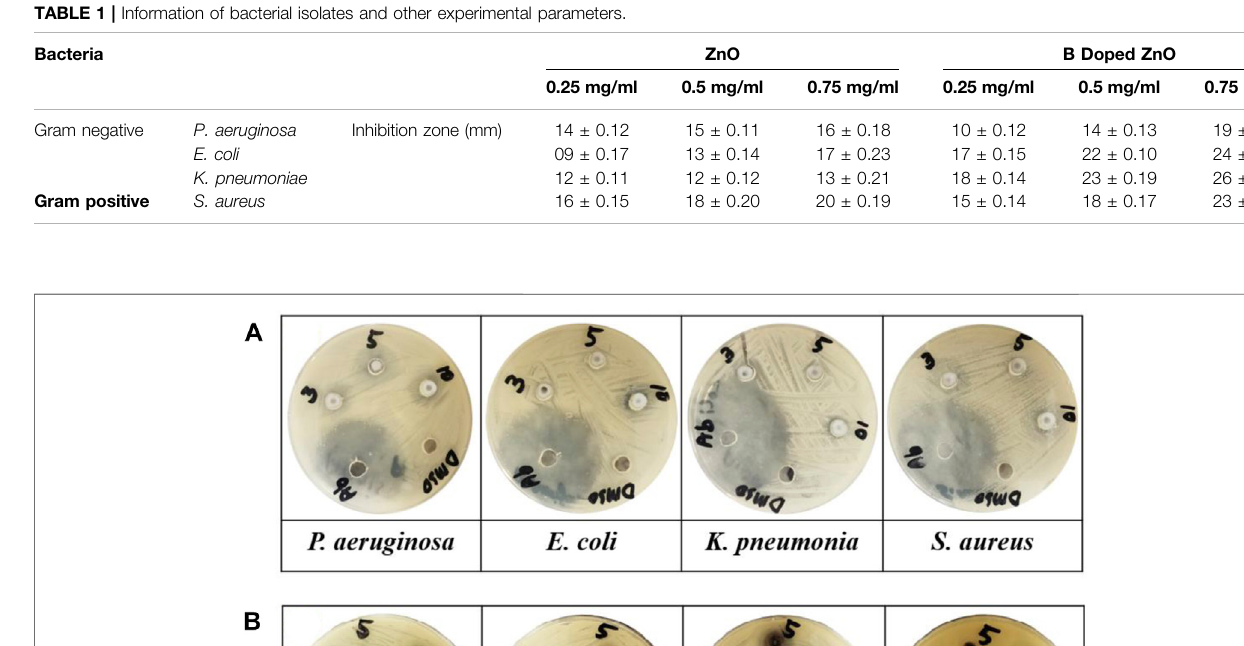
Frontiers in Chemistry |